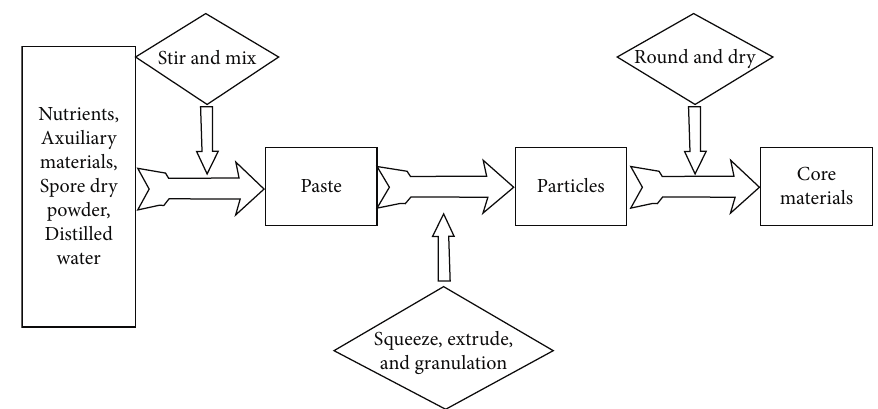
Figure 3: The flowchart of preparing the core